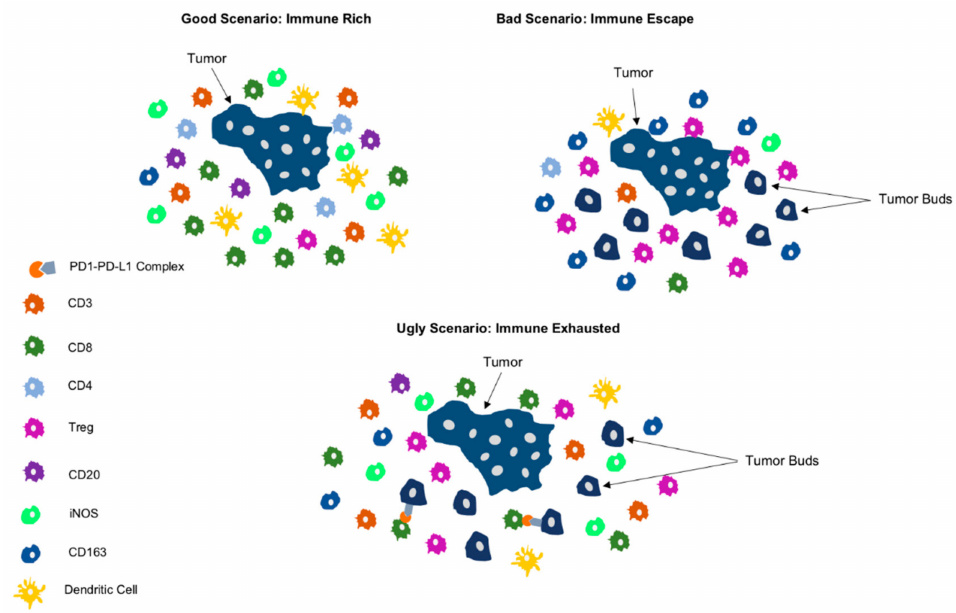
Figure 2. Schematic representation depicting the three main immunophenotypes of pancreatic cancer. The immune rich phenotype displays marked infiltration through cytotoxic T-cell populations, including CD3 + , CD8 + and CD4 + cells, while the immune escape phenotype shows increased Foxp3 + Tregs and macrophages with M2 polarization (CD163 + ), along with many tumor buds. The immune exhausted phenotype shows upregulation of PD-L1 and an inflamed microenvironment with presemce of many tumor